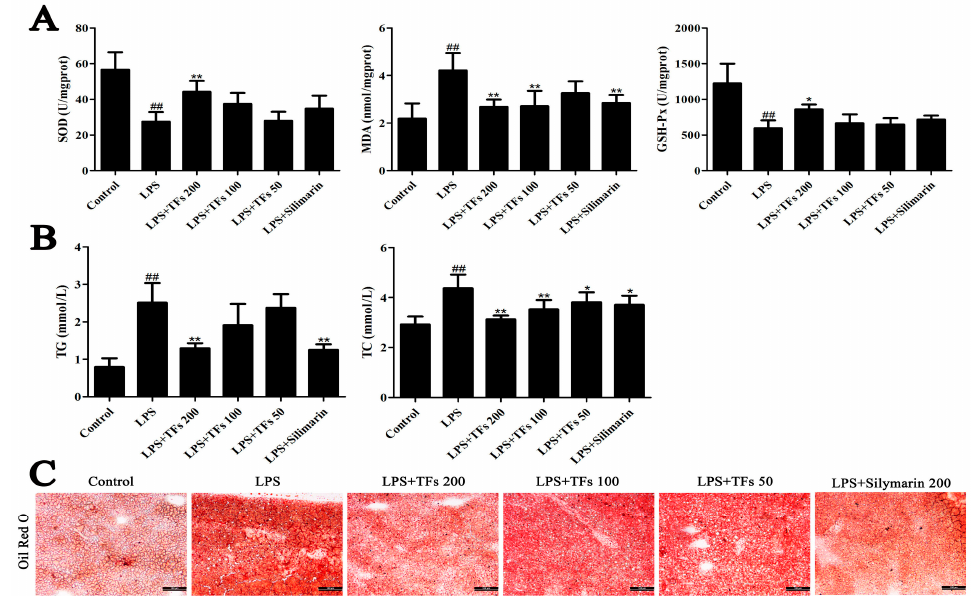
Figure 2. Effects of TFs on LPS-induced oxidative stress and lipid metabolism in mice. ( A ) Effectsof TFs on SOD (superoxide dismutase), MDA (malondialdehyde), and GSH-Px (glutathione peroxidase) levels in the livers of control mice and mice undergoing different treatments. ( B ) Effects of TFs on serum TG (total triglyceride) and TC (total cholesterol) levels in mice. ( C ) Oil Red O staining of liver tissues (200× magnification). The values are expressed as the mean ± SD ( n = 8); ## p < 0.01 versus control group; * p < 0.05and ** p < 0.01 versus model group.